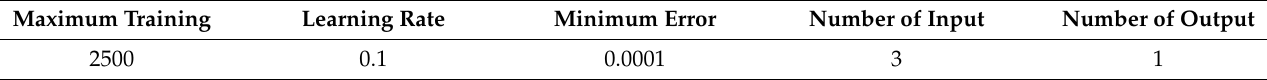
Figure 2. Neural network structure chart. The neural network parameter settings are shown in Table 1. Table 1. Parameter of neural network.